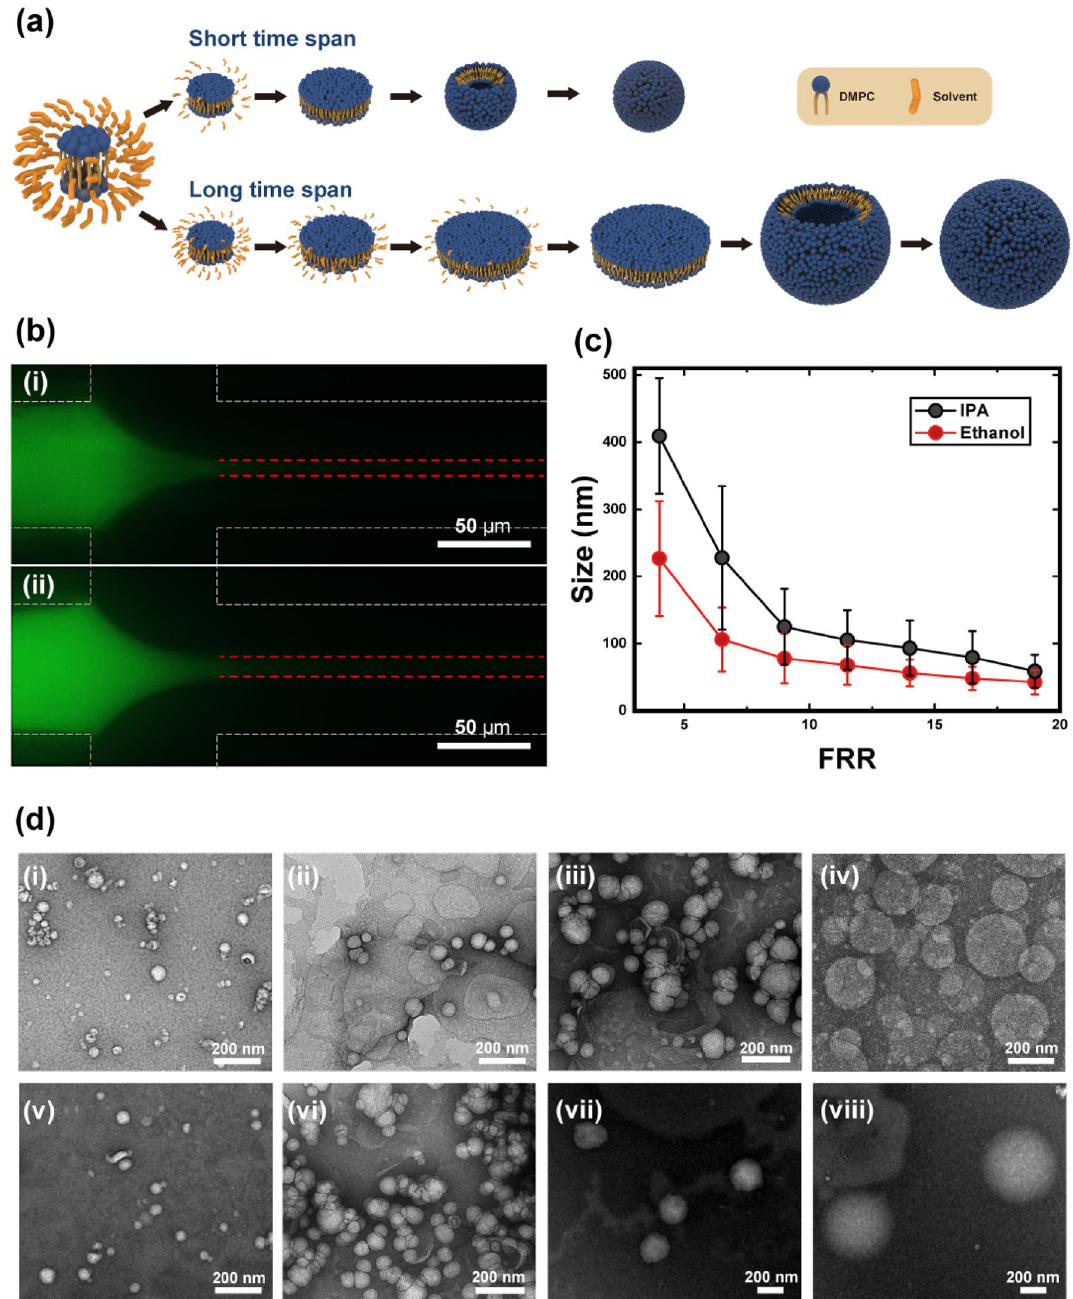
Figure 1. ( a ) Vesiculation of the bilayer domain according to the time span for self-assembly. Upper side represents a short time span case (corresponding to fast depletion of the solvent); lower side shows slow vesiculation over a longer time span. ( b ) Fluorescence image of a focused stream according to the solvent (total flow rate = 2000, flow rate ratio (FRR) = 9, (i) Ethanol, (ii) isopropyl alcohol (IPA), Scale bar = 50 µm). ( c ) Size of the liposome depending on the FRR for two different solvents. Red and black circles represent ethanol and IPA, respectively. ( d ) TEM images of the liposomes prepared using ethanol and IPA at (i, v) FRR = 19, (ii, vi) FRR = 11.5, (iii, vii) FRR = 6.5, and (iv, viii) FRR = 4 (Scale bar = 200